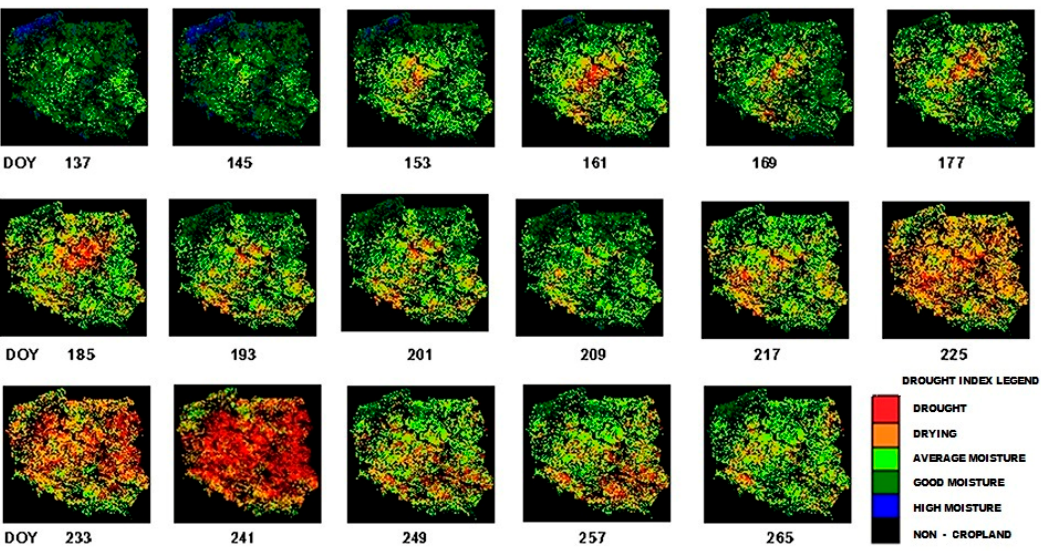
Figure 15. Distribution of the DISS Moderate-resolution Imaging Spectroradiometer (MODIS) drought index in the 2015 growing season.